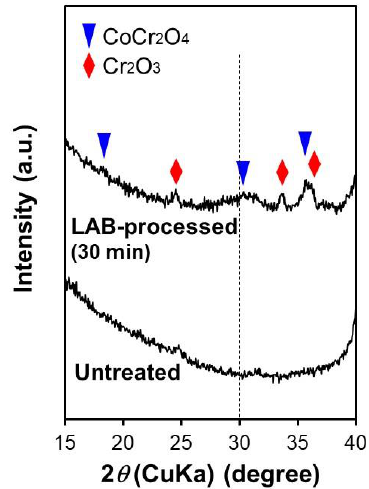
Figure 3. Thin-film X-ray diffraction (TF-XRD) patterns of the surfaces of the untreated and LAB-processed (30 min) Co−Cr alloy substrates.